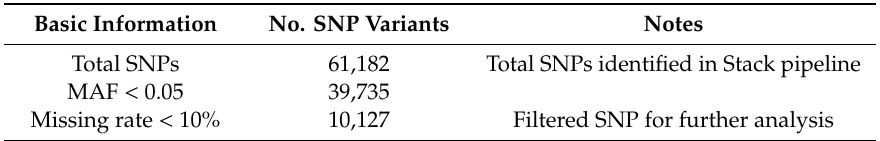
Table 2. Number of putative single nucleotide polymorphisms (SNPs) retained following each filtering